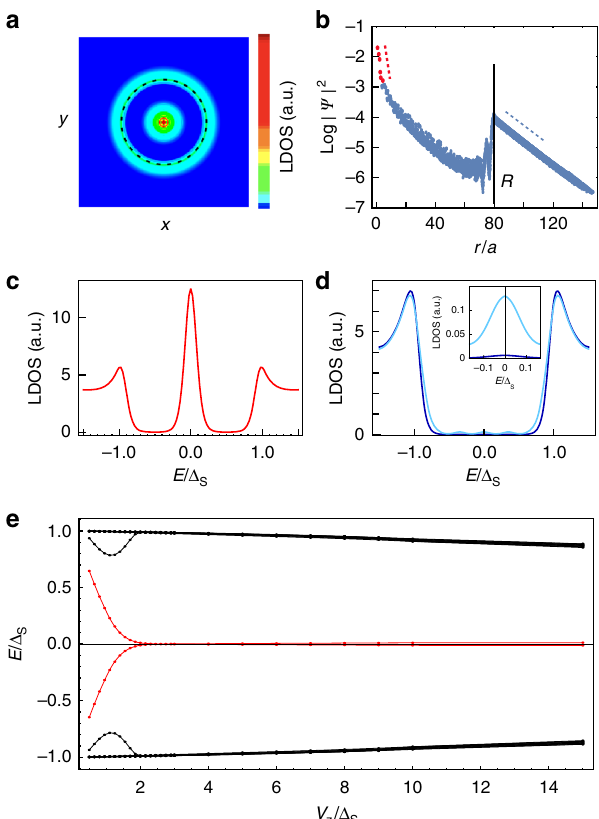
Fig. 2 Theory of spin – orbit defect and magnetic exchange. a Map of the local density of states (LDOS) at zero energy in the model of Eq. (1) solved in a circular system with a single spin – orbit vortex at the center of a disk (dashed line), which has constant magnetic exchange V z = 5 Δ S , and V z = 0 outside, while all system parameters are ( ξ / a , R / a , l V / a , l F / a , l SO / a ) = (400; 300; 80; 45; 3.3) (see Methods for de fi nitions and technical details), where superconducting coherence length ξ is larger than disk radius R , and system size is L = 8000. This LDOS is contributed by exactly two Majorana zero-mode wavefunctions. b Angularly averaged amplitude of the wavefunction at zero energy (dashed lines are guide to eye). The superconducting coherence length ξ / a = 20 is smaller than disk radius R / a = 80 (vertical line) in a system of size L = 300. See Methods for de fi nitions, parameter values and technical details of the two-dimensional tight-binding calculation of model Eq. (1). c Energy-dependent LDOS at the center of the island with a thermal broadening of k B T / Δ S = 0.1. d Energy- dependent LDOS at the edge of the magnetic disk (light blue curve) and inside the magnetic disk at distance 0.75 R from the center (dark blue curve). The inset show a zoom on the zero-bias density of states, revealing a well-de fi ned zero-bias peak. e Spectrum of excitations in superconductor of pairing energy Δ S for spin – orbit vortex — anti-vortex pair in a plane of size L = 450 with periodic boundary conditions and with constant magnetic exchange V z (see Methods). The lowest energies are plotted for each V z , with lowest two in red. Above a critical magnetic exchange two